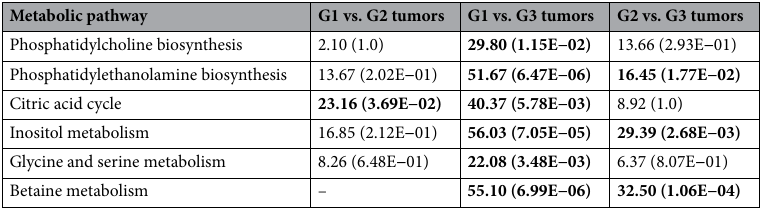
Table 3. Fold enrichment values (and the Holm p values) obtained from the enrichment analysis for the most important metabolic pathways perturbed in EC: G1 vs. G2, G1 vs. G3 and G2 vs. G3. The bolded fold enrichment scores indicate the metabolic pathways characterized by the Holm p value <